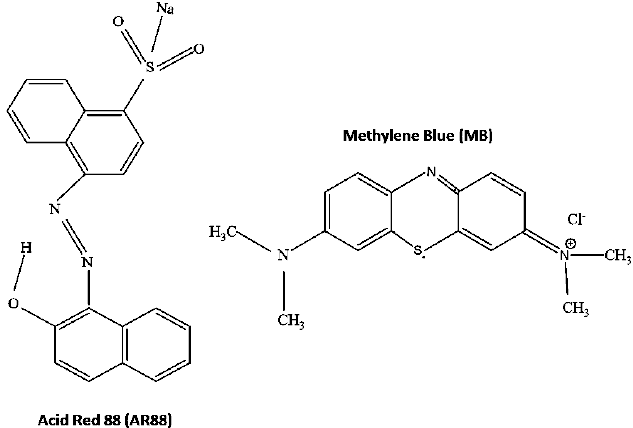
Figure 12. The structure of AR88 [62,63] and MB